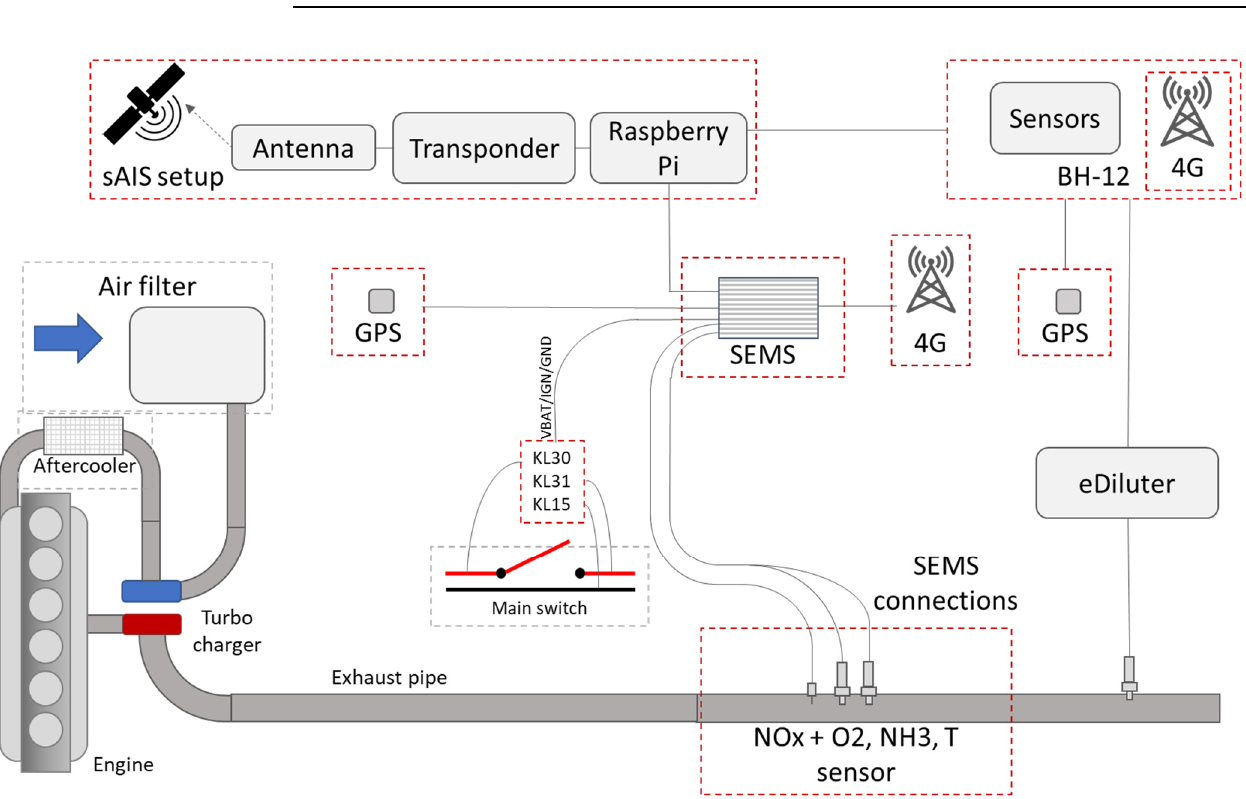
Figure 2. The SEMS system integrated with S-AIS transmission used in Trials 2 and 3. Generalised schematic but based on the setup on the Stena